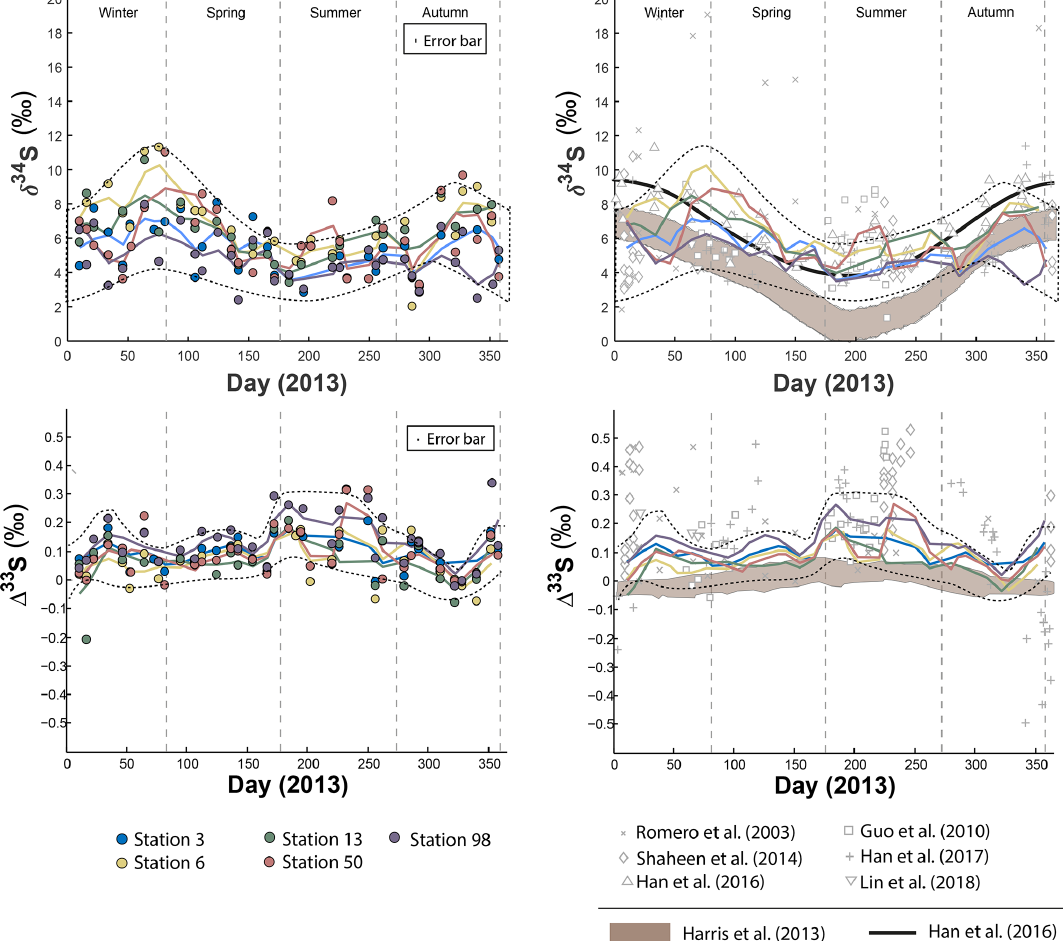
Figure 1. Sulfate δ 34 S and (cid:49) 33 S variations over time in Montreal PM 10 aerosols. Grey bands represent the modelled sulfate isotope charac- teristics if SO 4 is formed following the oxidation pathways proposed by Harris et al.